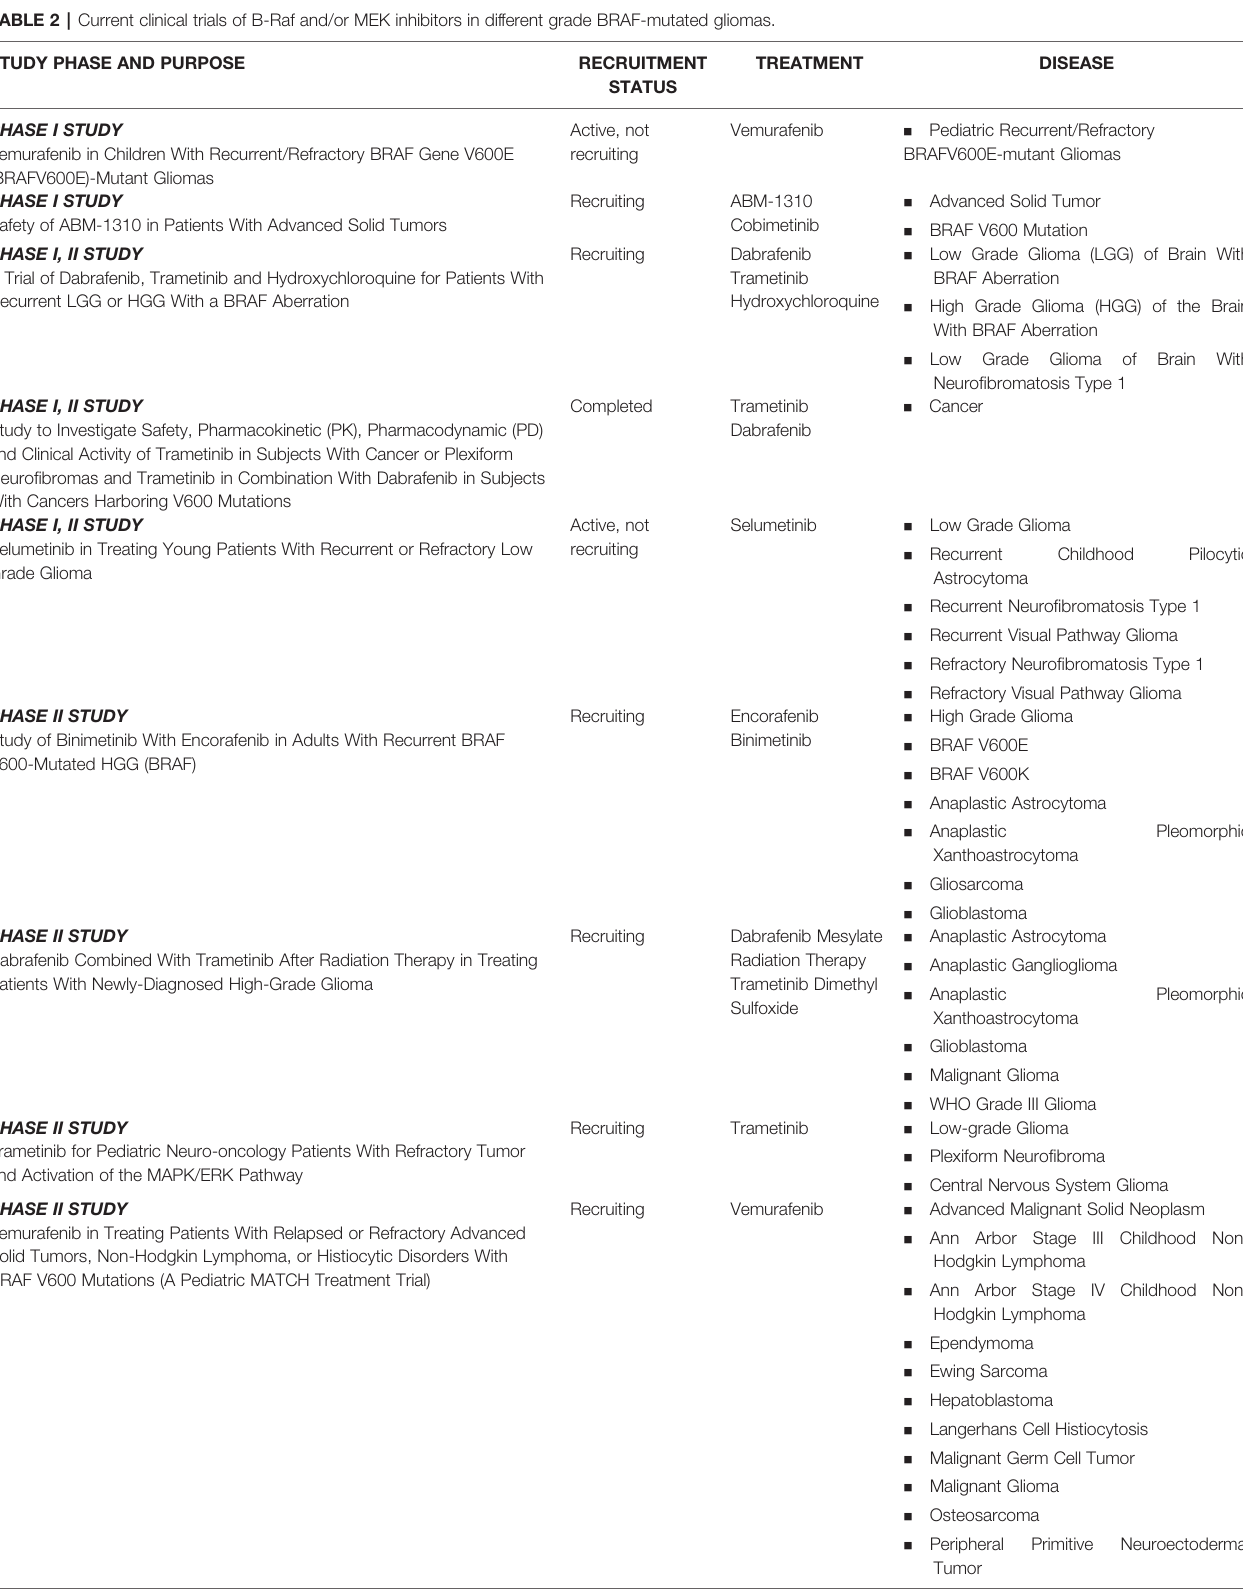
TABLE 2 | Current clinical trials of B-Raf and/or MEK inhibitors in different grade BRAF-mutated